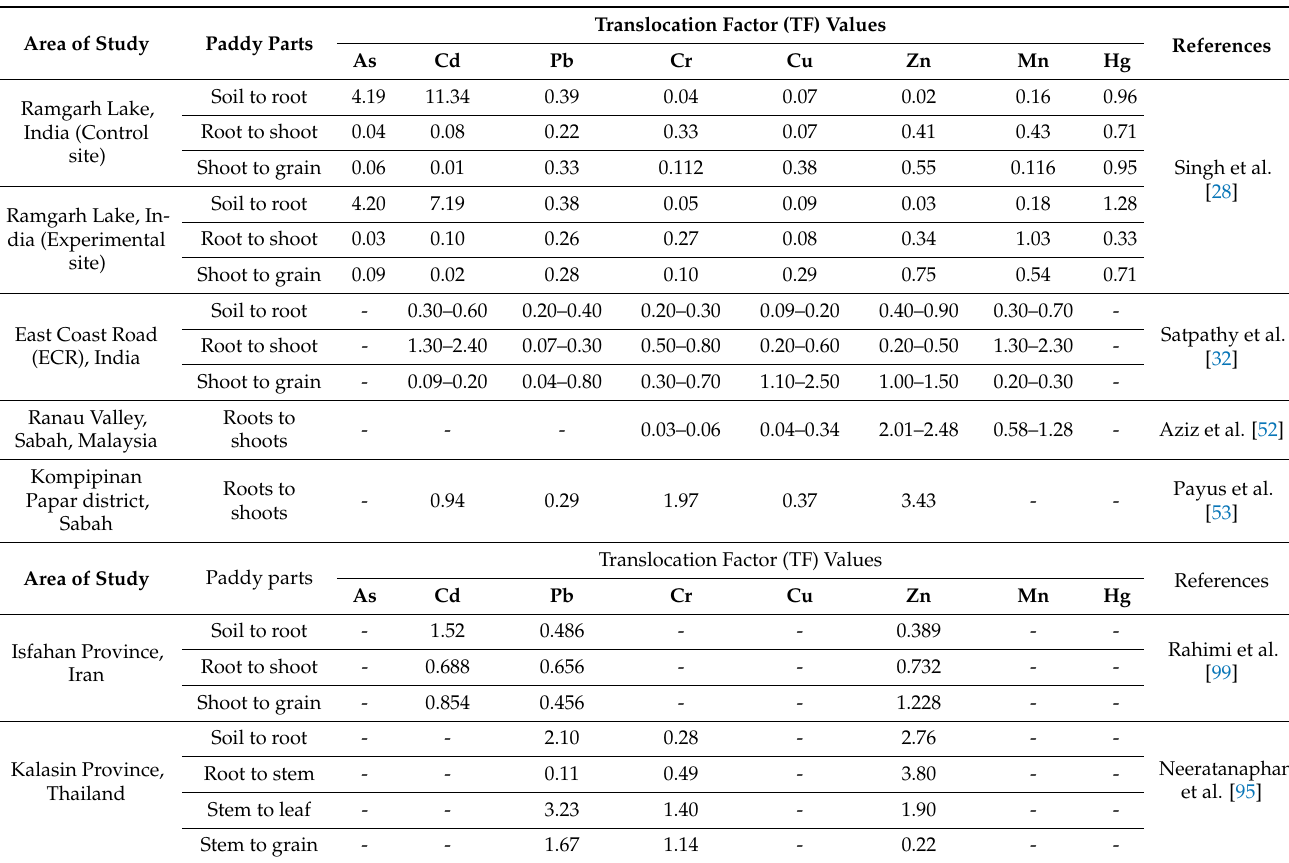
Table 3. Summary of the translocation factor (TF) values in paddy plants from different